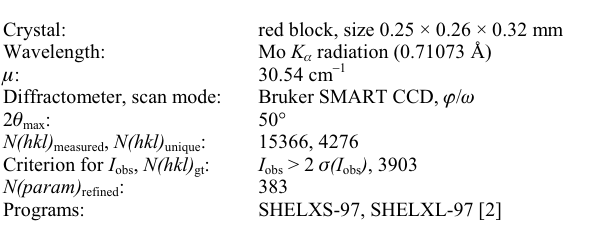
Table 1. Data collection and